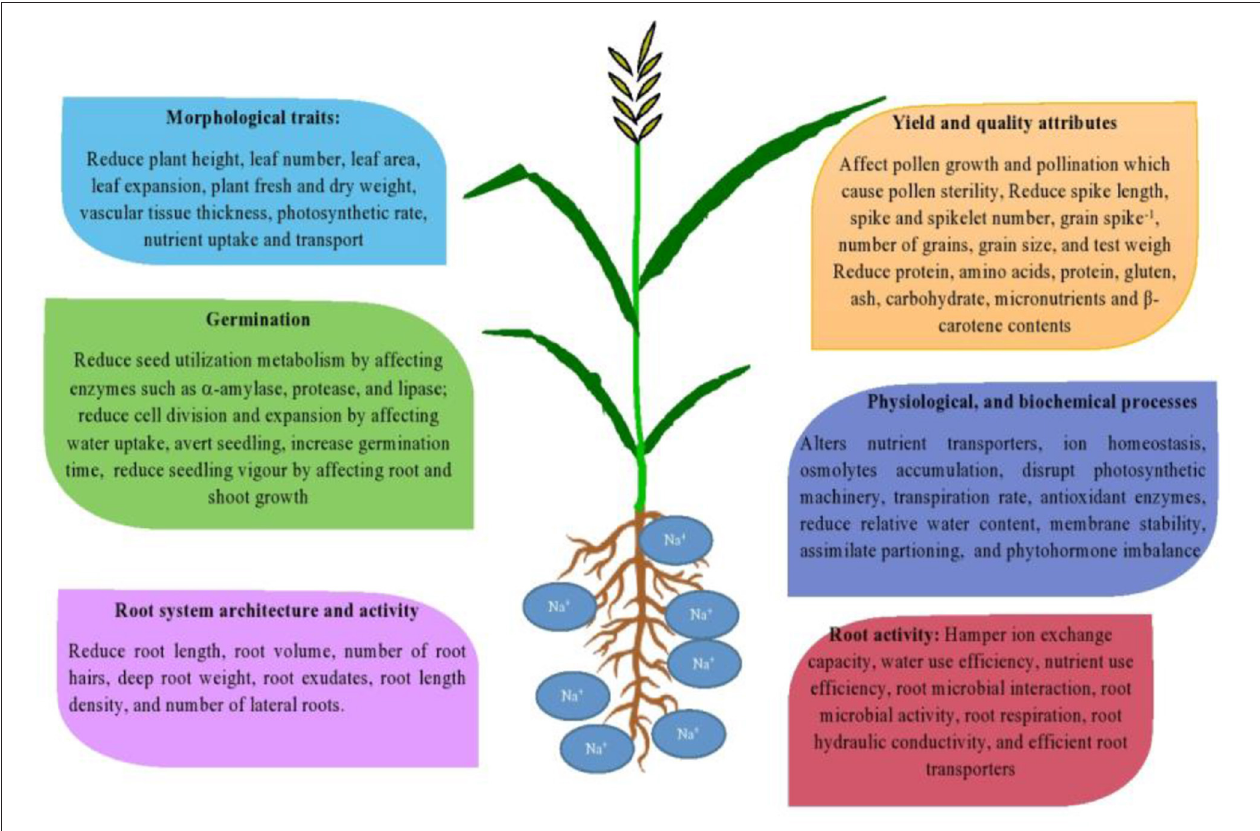
FIGURE 1 | Illustrates the effects of salinity stress on different growth stages and crucial plant processes.